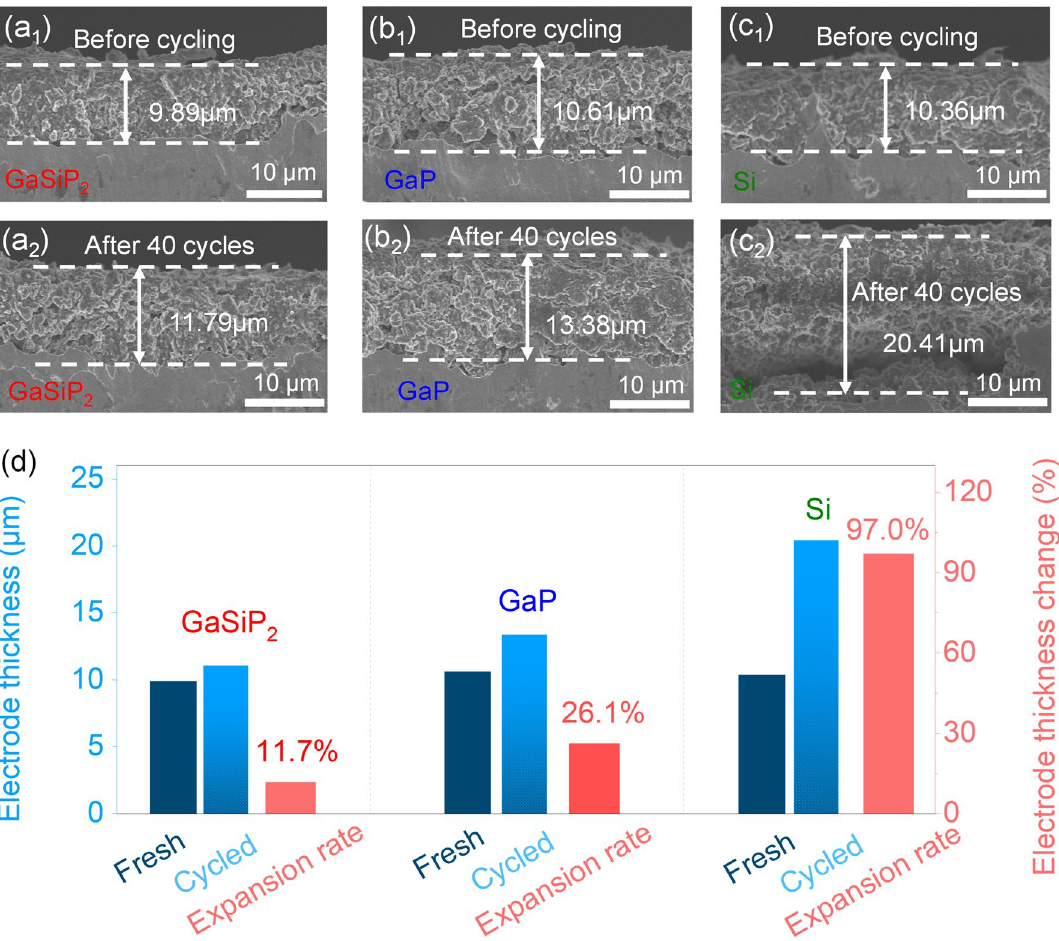
Fig. 5 Cross-section images of the GaSiP 2 , GaP and Si: a 1 – c 1 Pristine electrodes; a 2 – c 2 Electrodes after 40 cycles; d Electrode thickness varia- tion and expansion